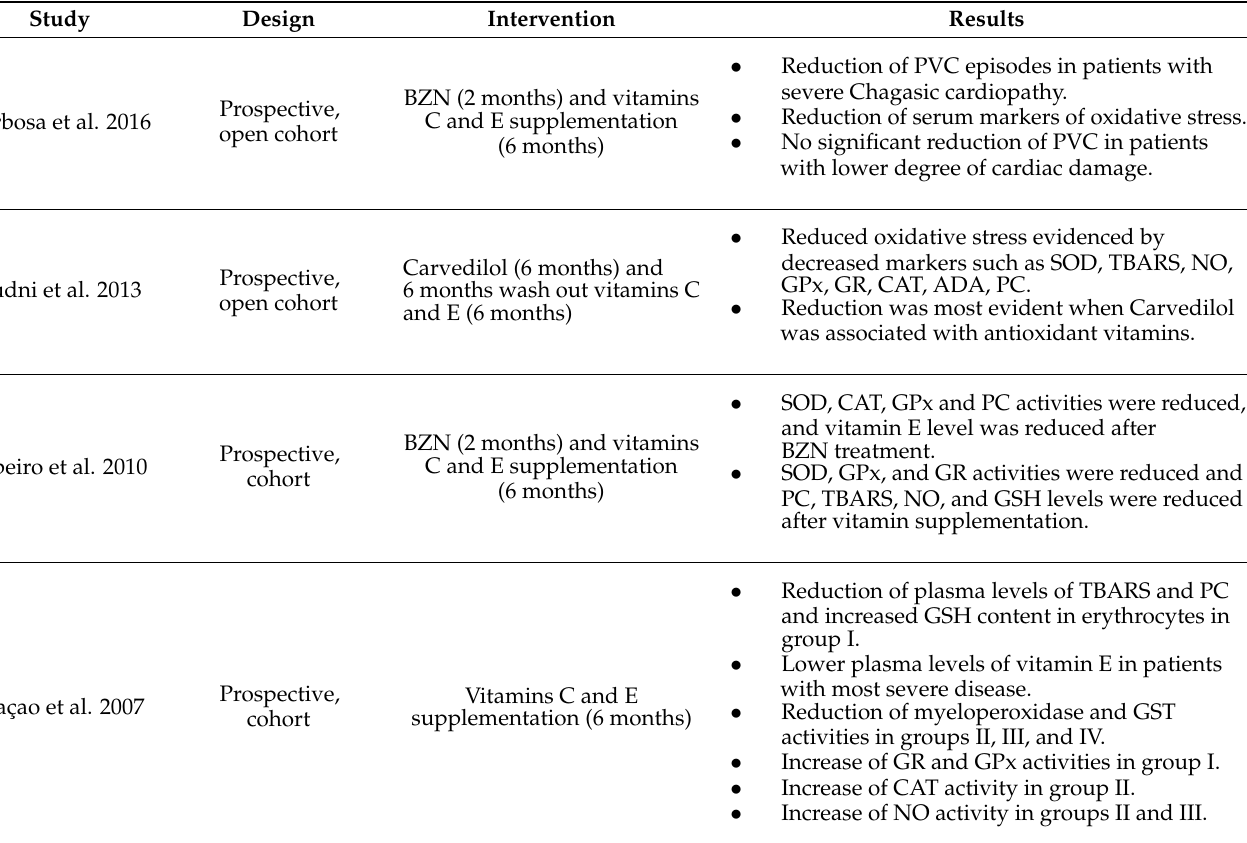
Table 2. Main results of antioxidants therapies in patients with Chagas